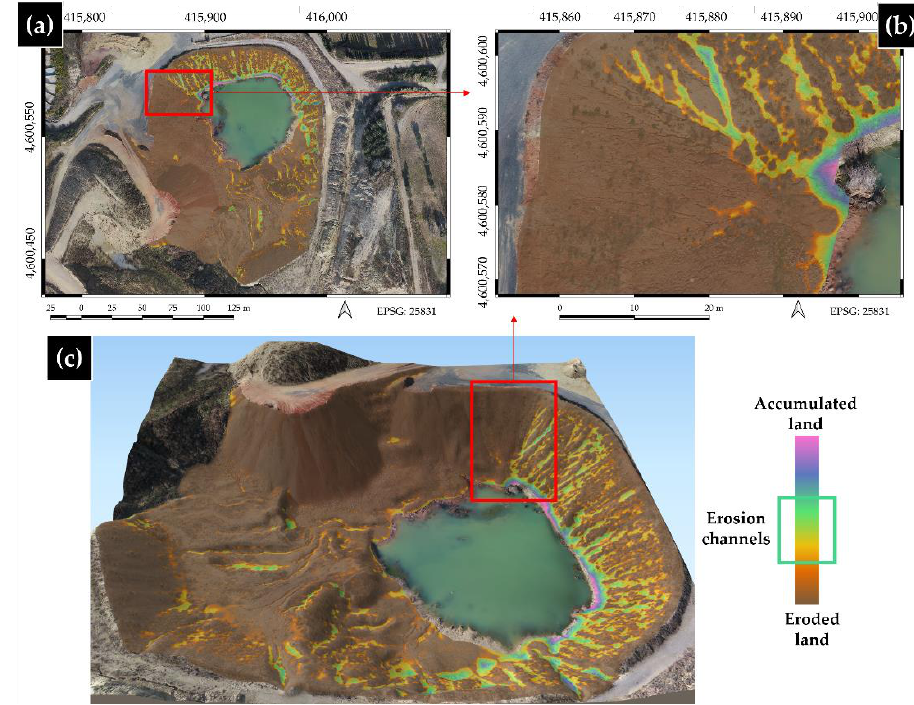
Figure 7. ( a ) Erosion map resulting from the difference between DEM T0 and DEM T1 (DoD) at the Area of Interest (AOI). ( b ) Detail of ( a ). ( c ) 3D representation of the erosion map at the AOI.